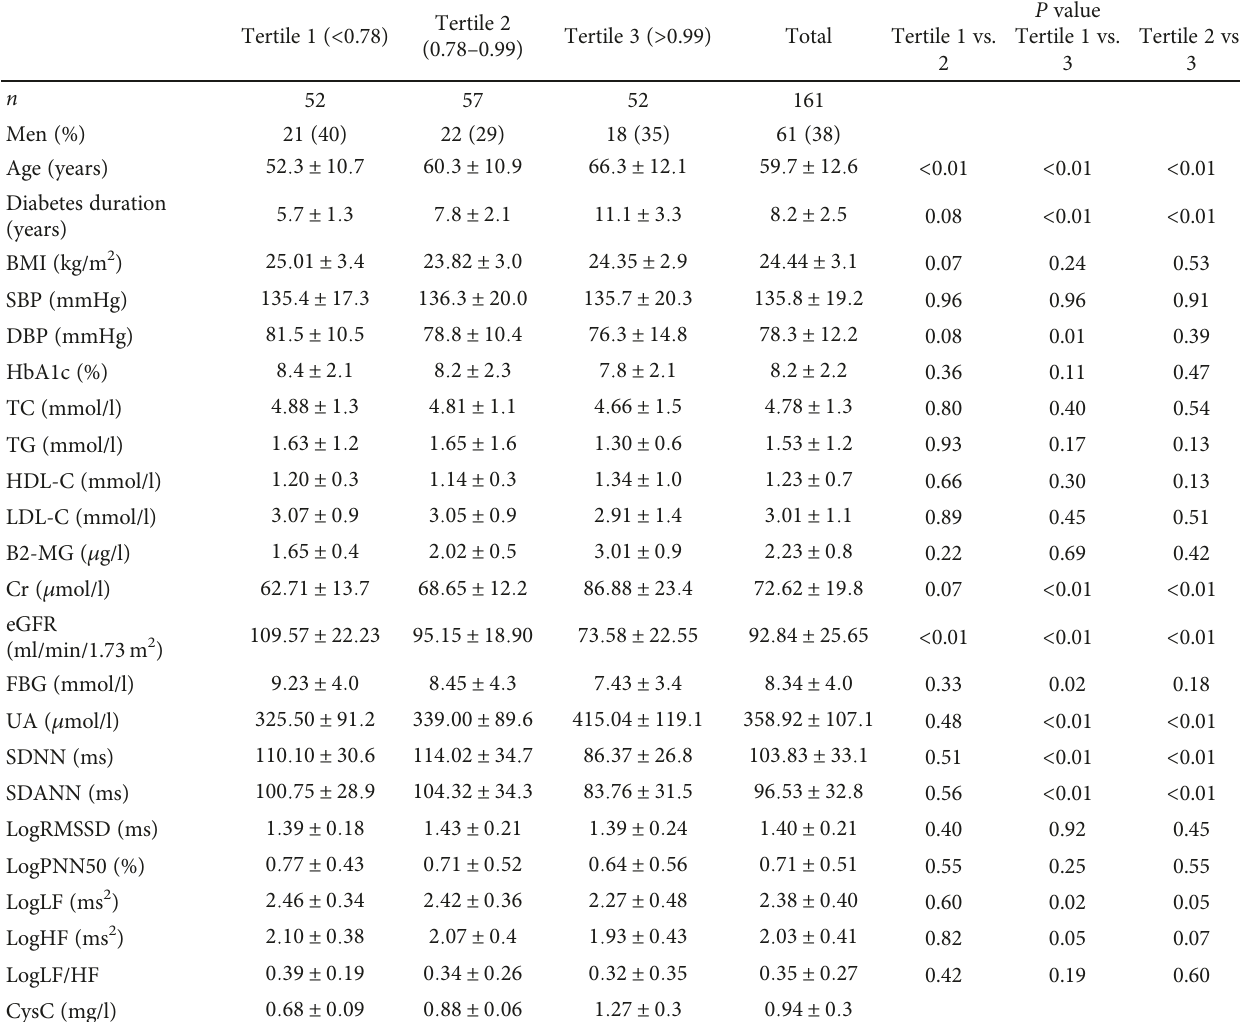
Table 1: Characteristics of patients with type 2 diabetes according to serum cystatin C